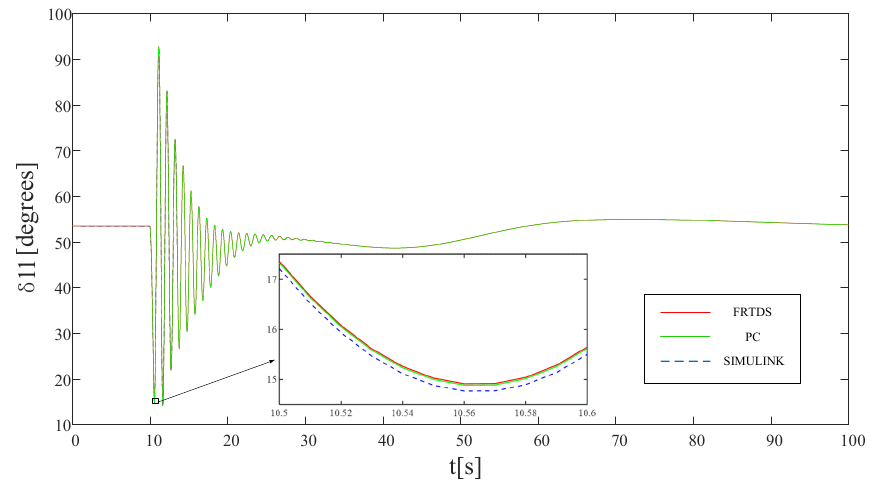
Figure 9. The power-angle of the generator connected to bus 11.